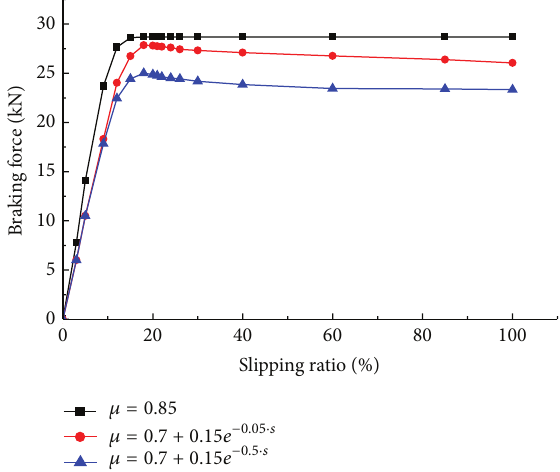
Figure 9: Braking force variation with different friction models.